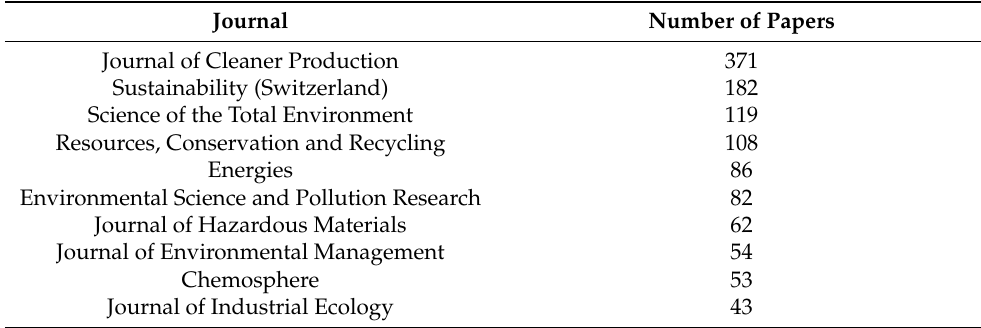
Table 3. Ranking of the top 10 journals, as identified through Scopus and Web of Science databases, which published indexed papers on environmental sustainability, environmental impacts and en- vironmental aspects related to circular economy in the steel life cycle. The results derived from the analysis of articles identified during the first round of bibliographical research and refer to works published between 2019 and 2023.